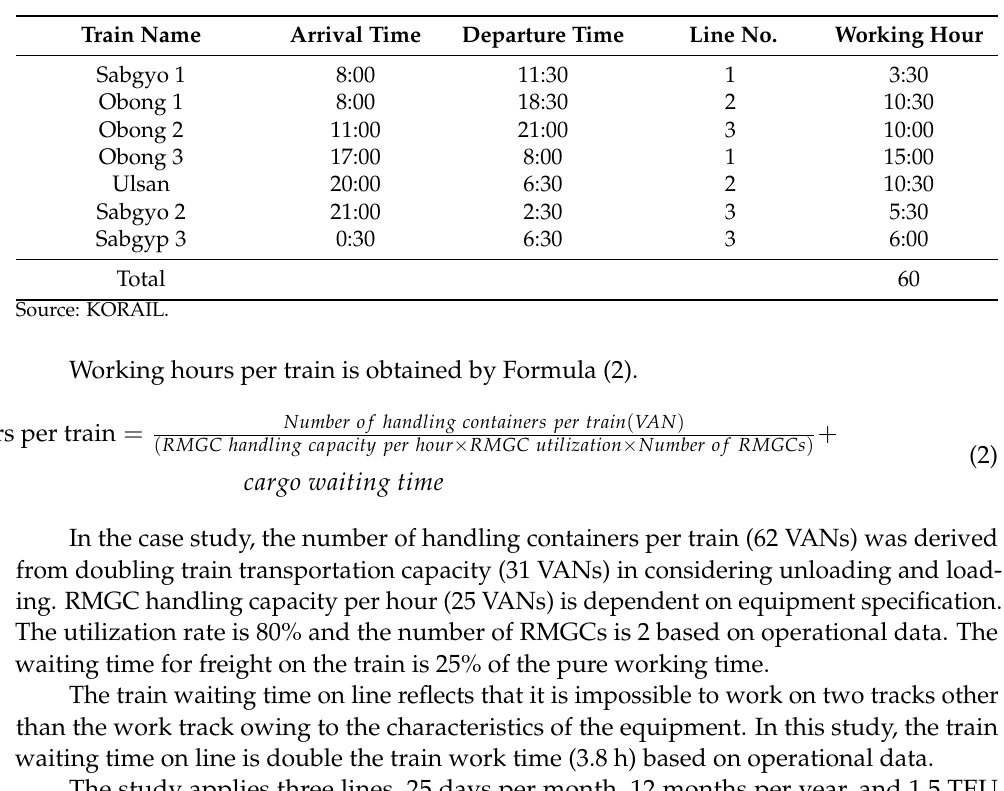
Table 1. Train working hours per